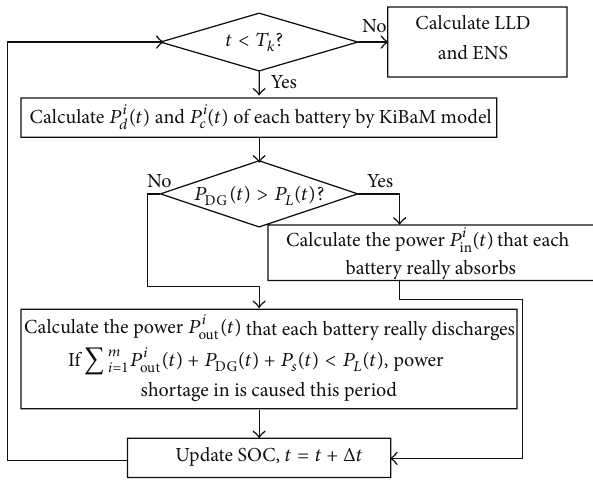
Figure 5: Simulation process in load-following